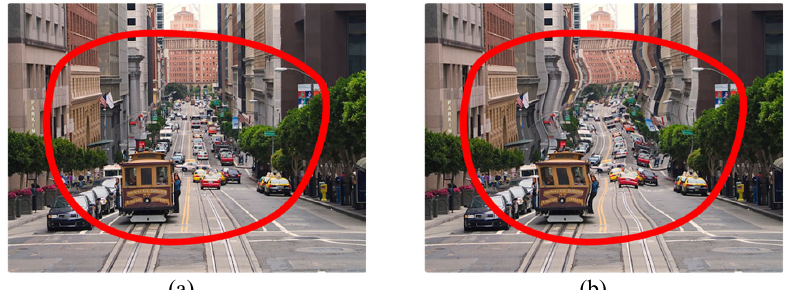
Fig. 1. Schematic illustrations of imaging distortion for viewing distant street scenes with spectacle lenses: (a) normal lens, (b) defective